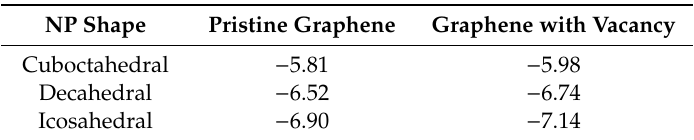
Table 1. The binding energies (eV) of the Au 561 NPs oriented with their (111) surface parallel to the graphene plane with and without a